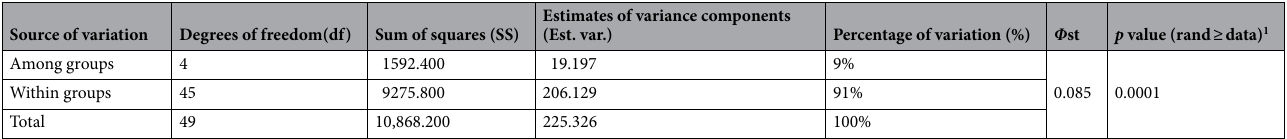
Table 4. Analysis of molecular variance (AMOVA) of rice in different regions. Probability of a random value greater than or equal to the observed data value based on permutation test ( n = 9999).